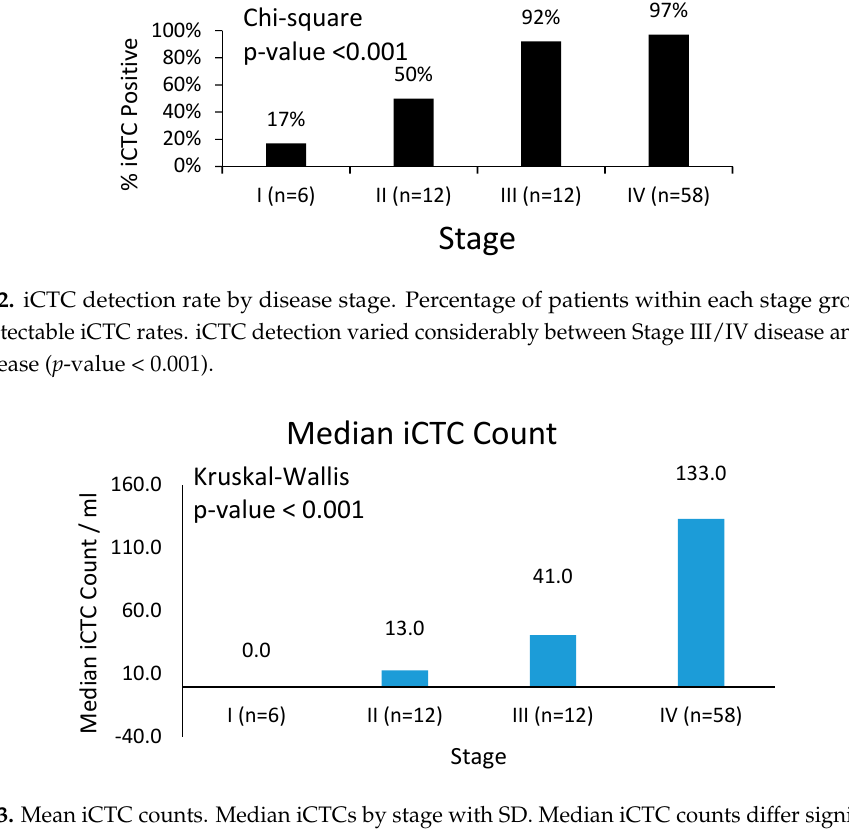
Figure 3. Mean iCTC counts. Median iCTCs by stage with SD. Median iCTC counts differ significantly between Stage IV disease and Stage I–III disease ( p -value < 0.001). Table 2. CTC detectability by stage.